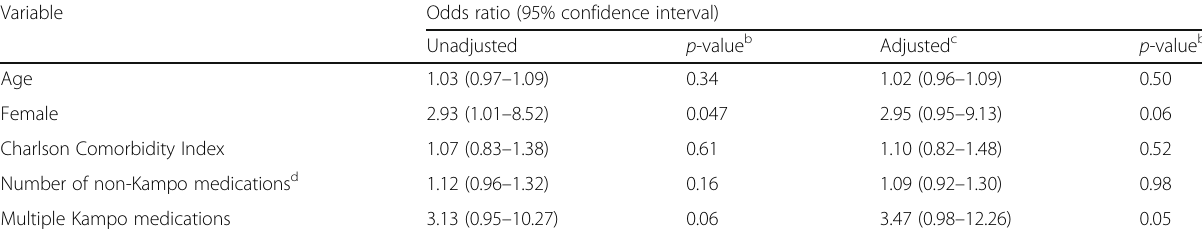
Table 4 Summary results of multivariable logistic regression analyses of predictive factors of the use of potentially inappropriate Kampo medications to be used with caution a